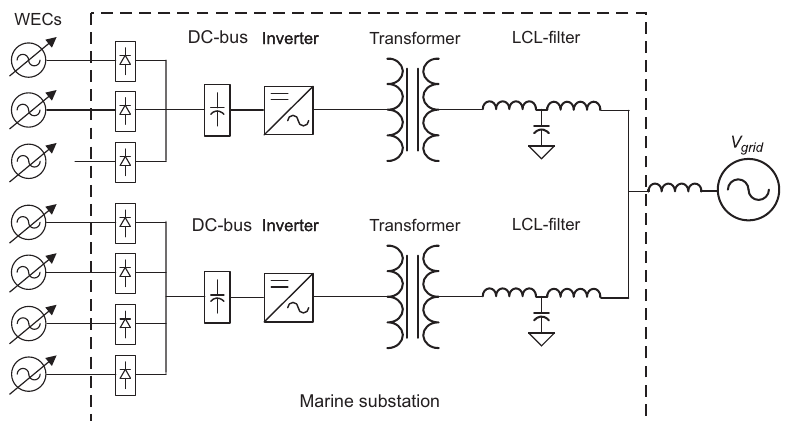
Figure 2. Electrical layout of the marine